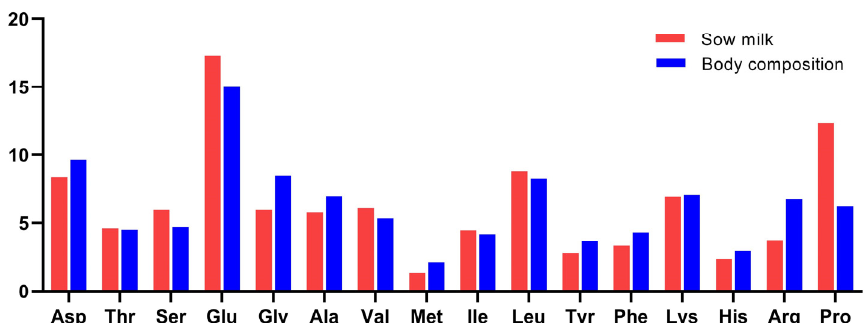
(% of total amino Figure 3. Amino acid pro fi le of sow milk in this study and whole piglet body in 8.5 kg body weight (% of total amino acid).